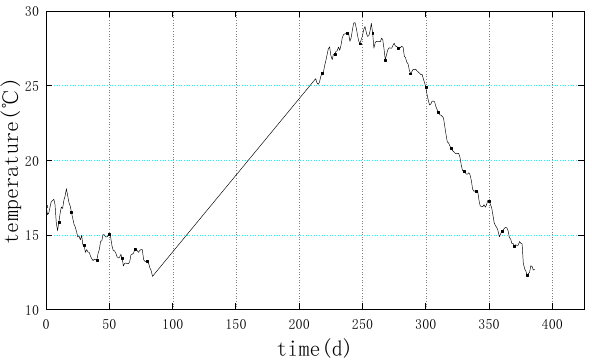
Figure 4. Time ‐ history plots of the temperature and humidity of the atmosphere of the laboratory room.